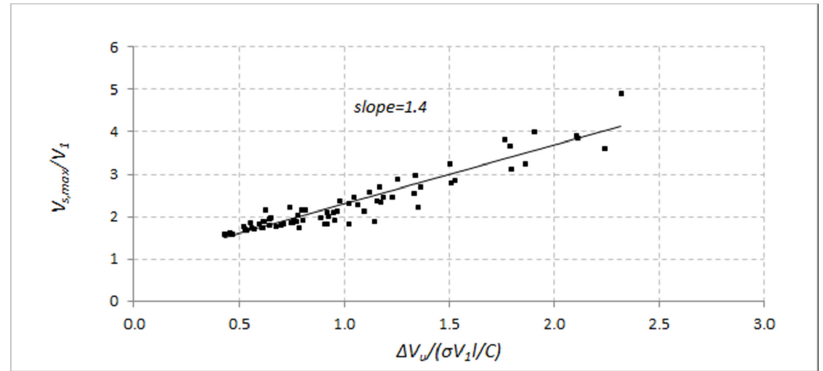
Figure 1. Linear correlation of maximum surface velocity ratio with circulation parameter for cascade test data [15].